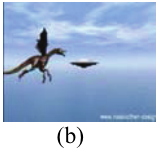
Fig. 6.1 (a) Results of the proposed CBVR system over games database: (i) input query clip and (ii) some of the retrieved video clips